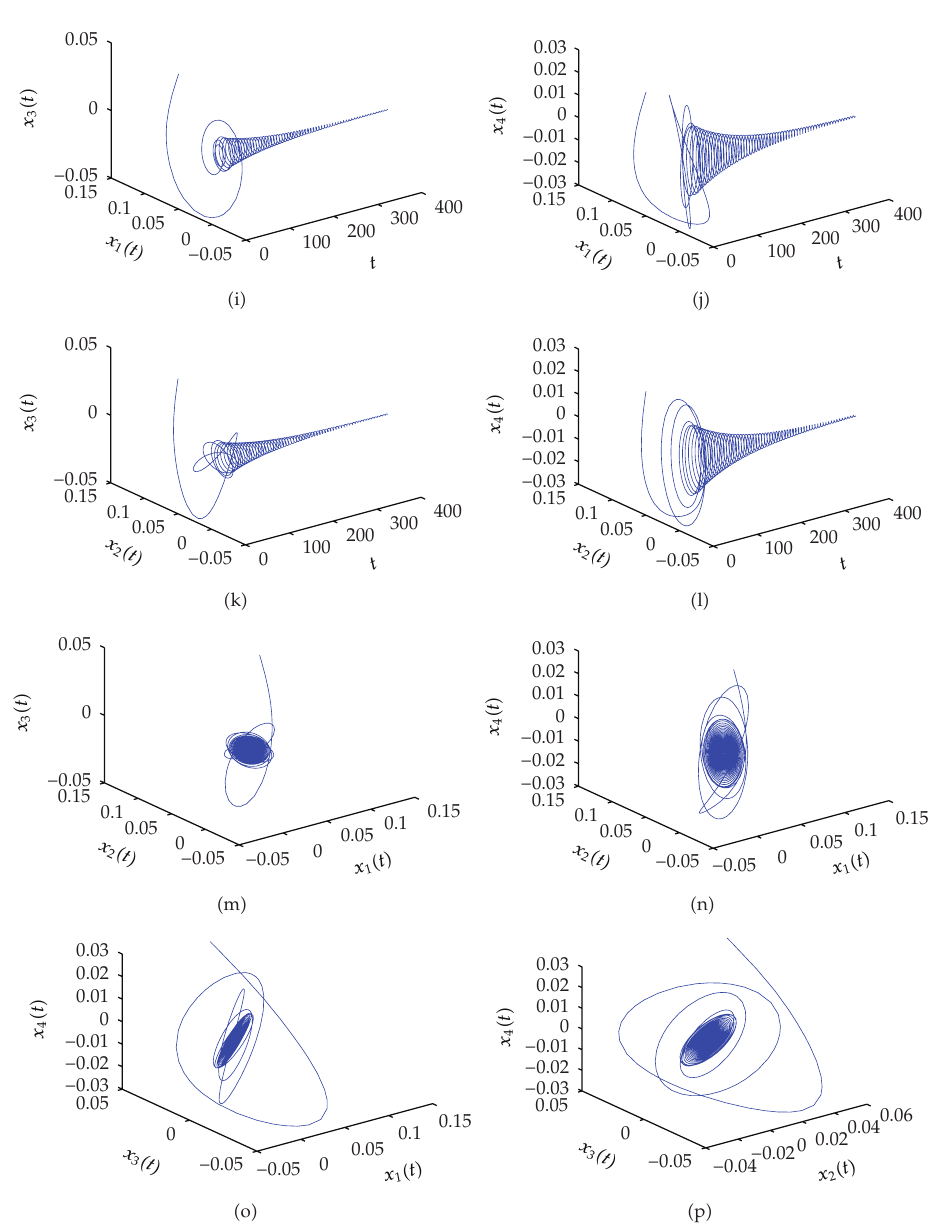
Figure 1: The time histories and phase trajectories of system (cid:7) 4.1 (cid:8) with τ (cid:5) 0 . 65 < τ 0 ≈ 0 . 6801 and the initial value (cid:7) 0.05, 0.05, 0.05, 0.025 (cid:8) . The equilibrium E 0 (cid:7) 0 , 0 , 0 , 0 (cid:8) is asymptotically stable.